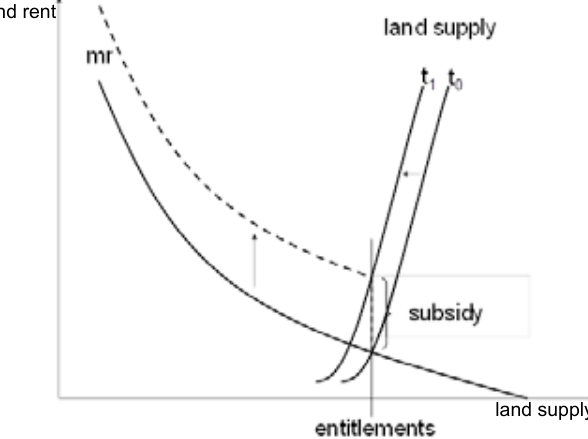
Figure 2. Effects of the SFP on land markets land rent